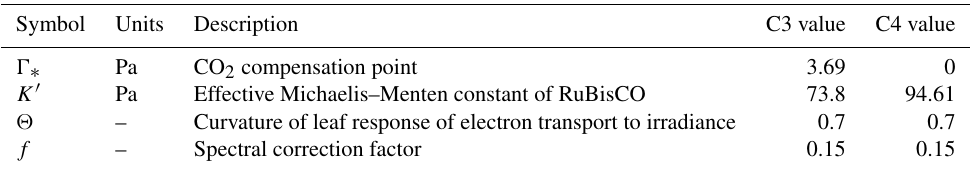
Table B1. Photosynthesis model constants according to dePury and Farquhar (1997) for C3 photosynthesis and adapted from Haxeltine et al. (1996) for C4